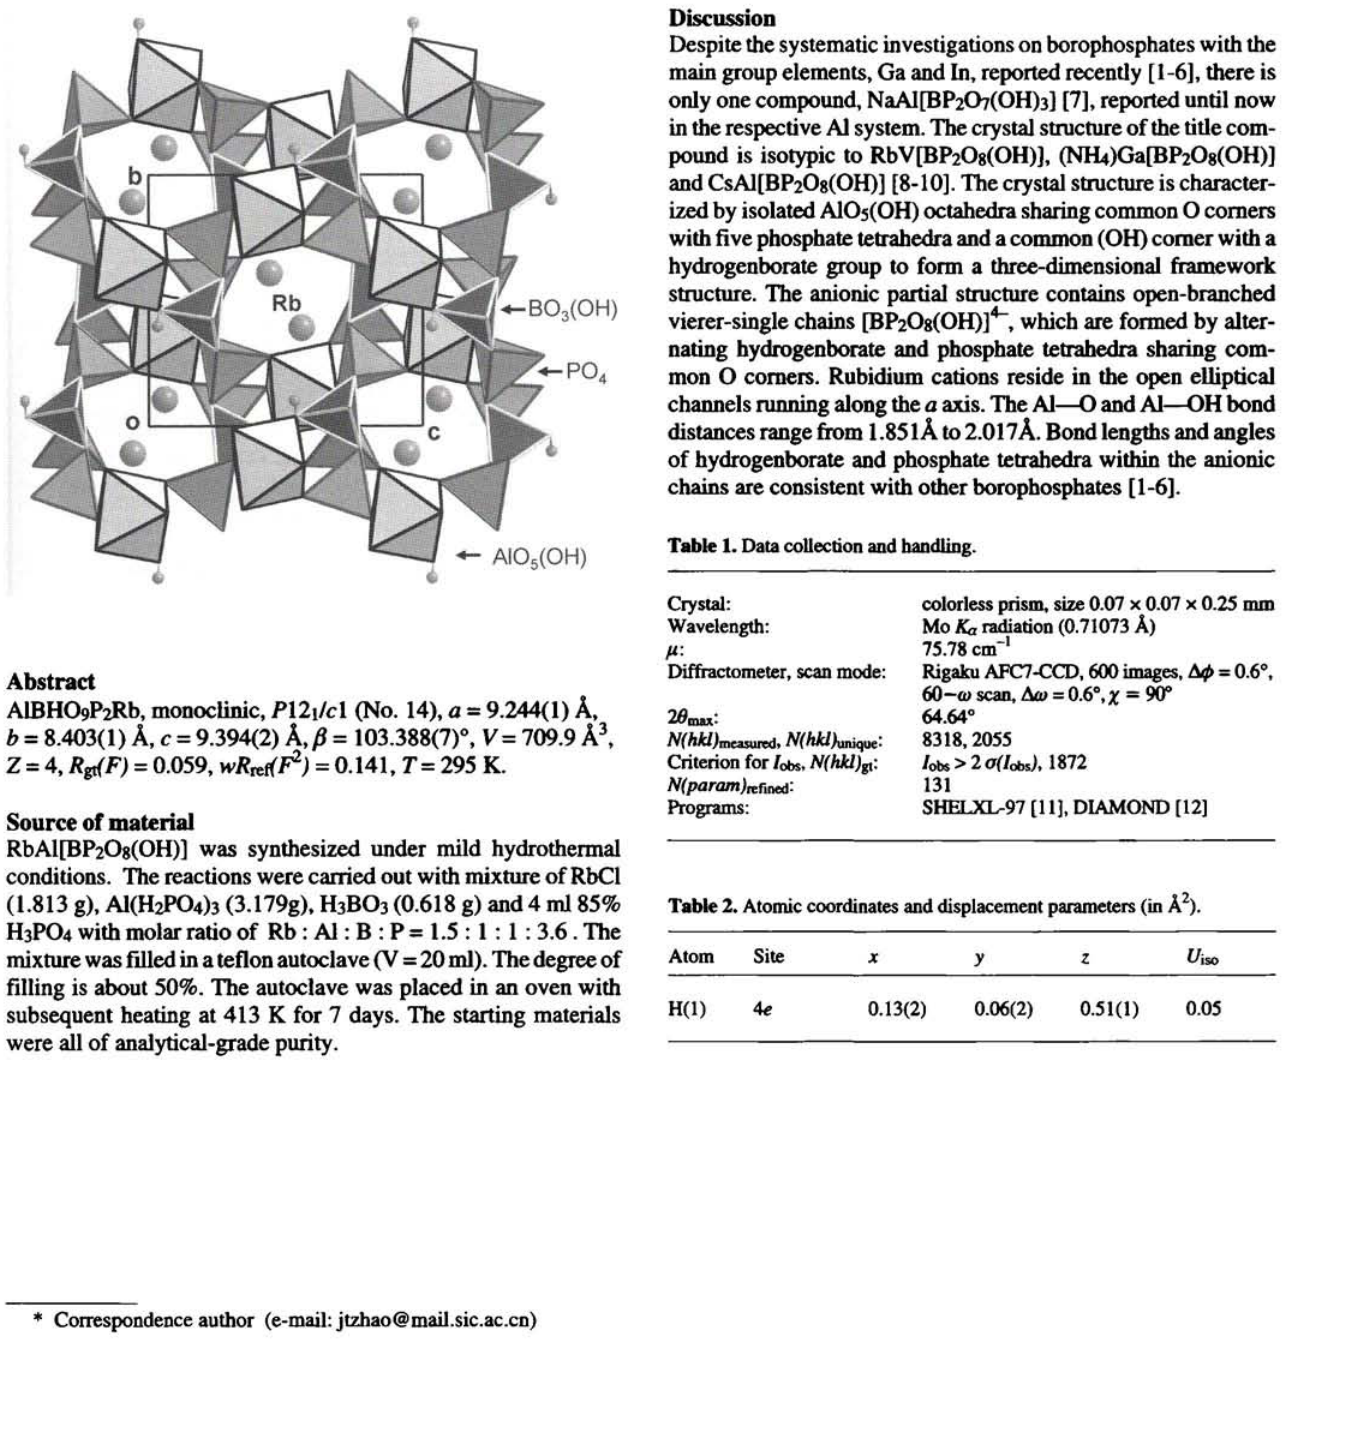
Table 2. Atomic coordinates and displacement parameters (in Â 2